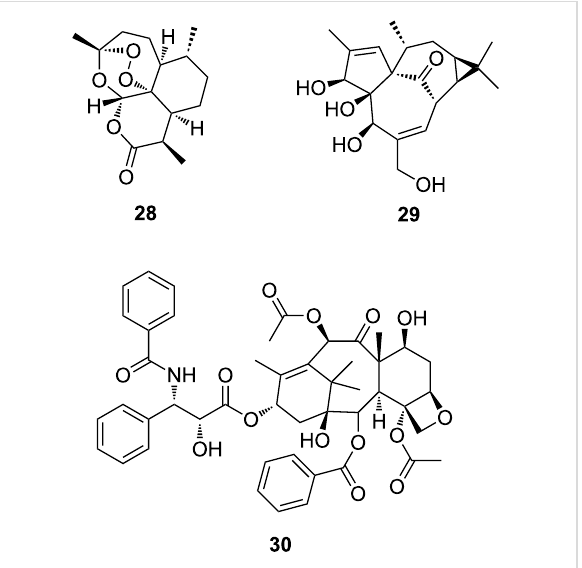
Figure 6: Structures of artemisinin ( 28 ), ingenol ( 29 ) and paclitaxel ( 30 ).